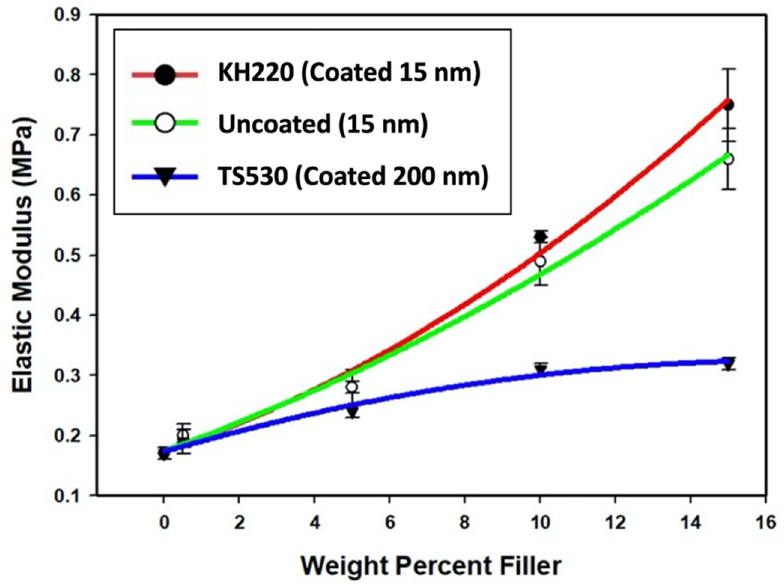
Figure 9. Plots of Mean Elastic Modulus (MPa) Versus Weight Percent Filler For Three Filler Types. Error Bars Represent Standard Errors of Means.